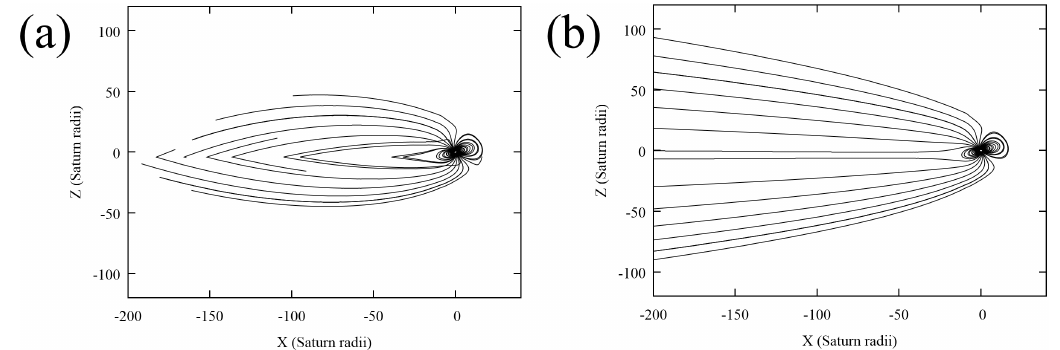
Figure 4. Projection onto the noon–midnight magnetospheric meridian of magnetic field lines starting from this plane (case 8 in Table 1); panel (a) shows results for the open magnetosphere model with penetration coefficient k = 0 . 2, while panel (b) shows results for the partially closed model with k = 0. The IMF vector is (0.5; − 2.0; − 1.4)nT.